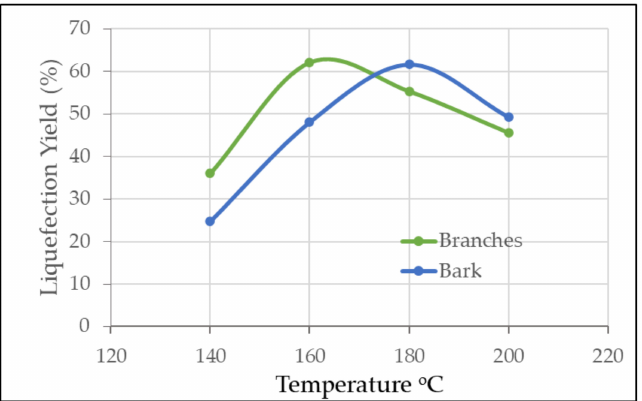
Figure 4. Effect of the reaction temperature on the liquefaction yield of bark and branches particles fraction > 80 mesh (powder) for 60 min with acid catalysis.